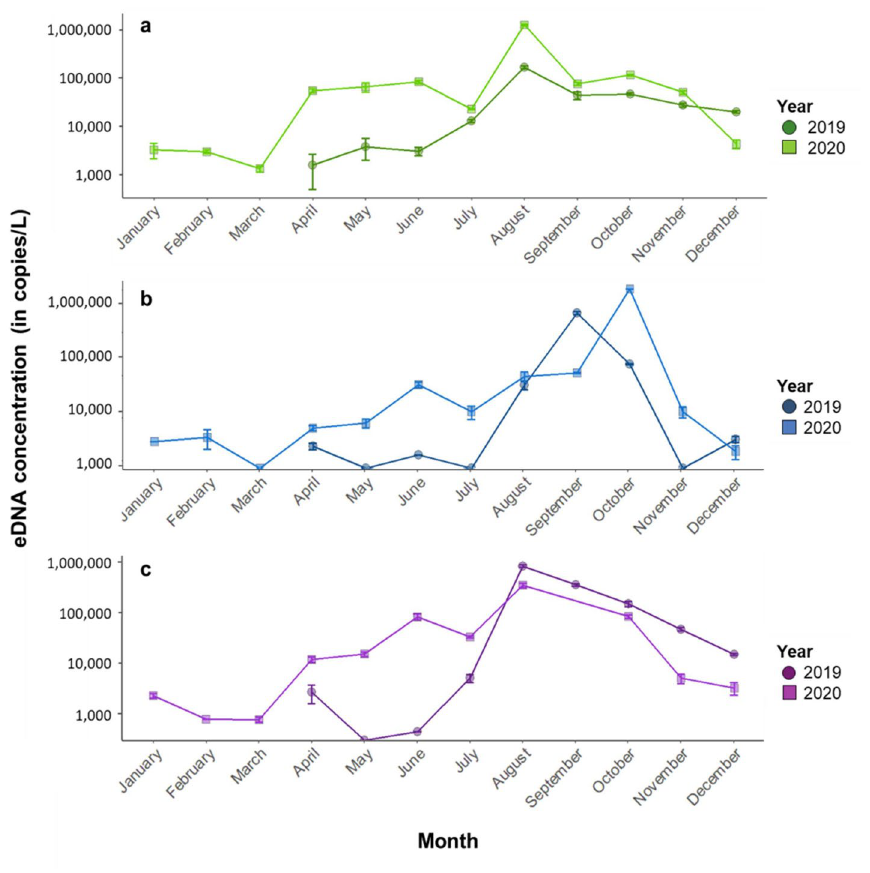
Figure 6. Monthly bullfrog eDNA concentrations on a logarithmic scale, expressed as the average (± 1 s.e.m.) number of copies per liter filtered water of three technical replicates per filter in three natural ponds known to be heavily infested by bullfrog, located at the core of the Belgian metapopulation (see Fig. 1): pond 1 ( a ), pond 2 ( b ), and pond 3 ( c ). Samples collected in 2019 and 2020 are represented by circles and squares, respectively. Pond 3 was not sampled in September 2020 as it had completely dried out. The intersection of the x-axis and y-axis corresponds to an eDNA concentration of